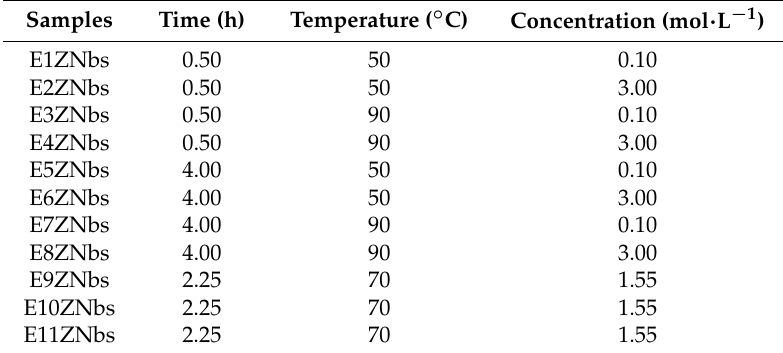
Table 1. Experimental design for basic treatment with